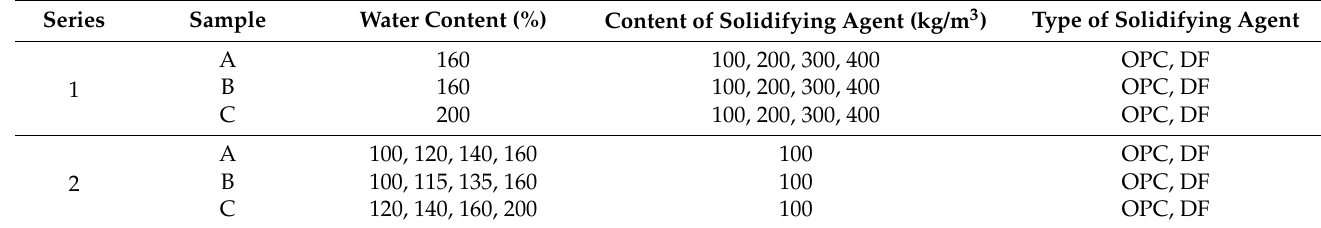
Table 3. List of experimental